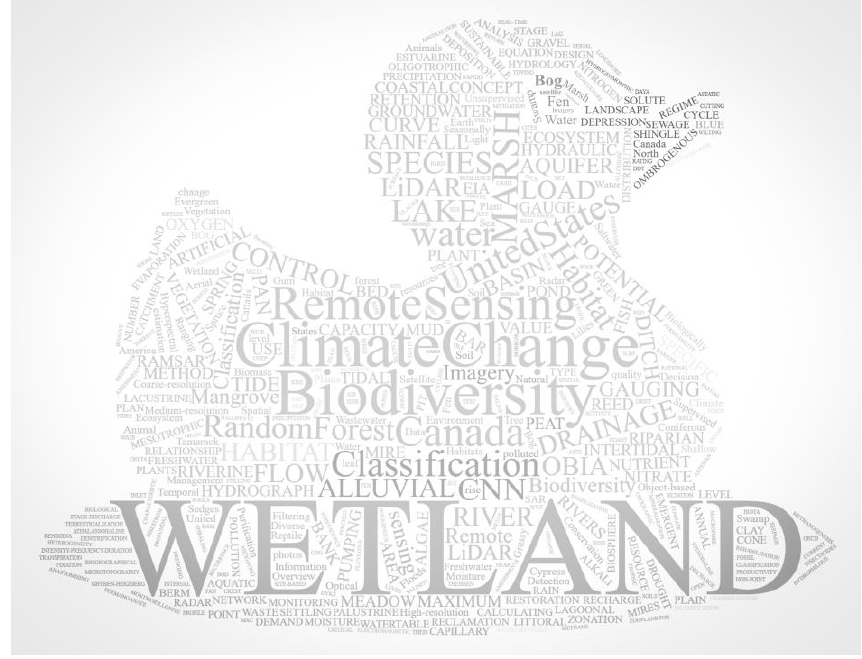
Figure 7. Tag cloud showing the highest frequency terms in North American wetland classification papers. The larger the text, the more frequently the word appeared in the wetland classification papers.